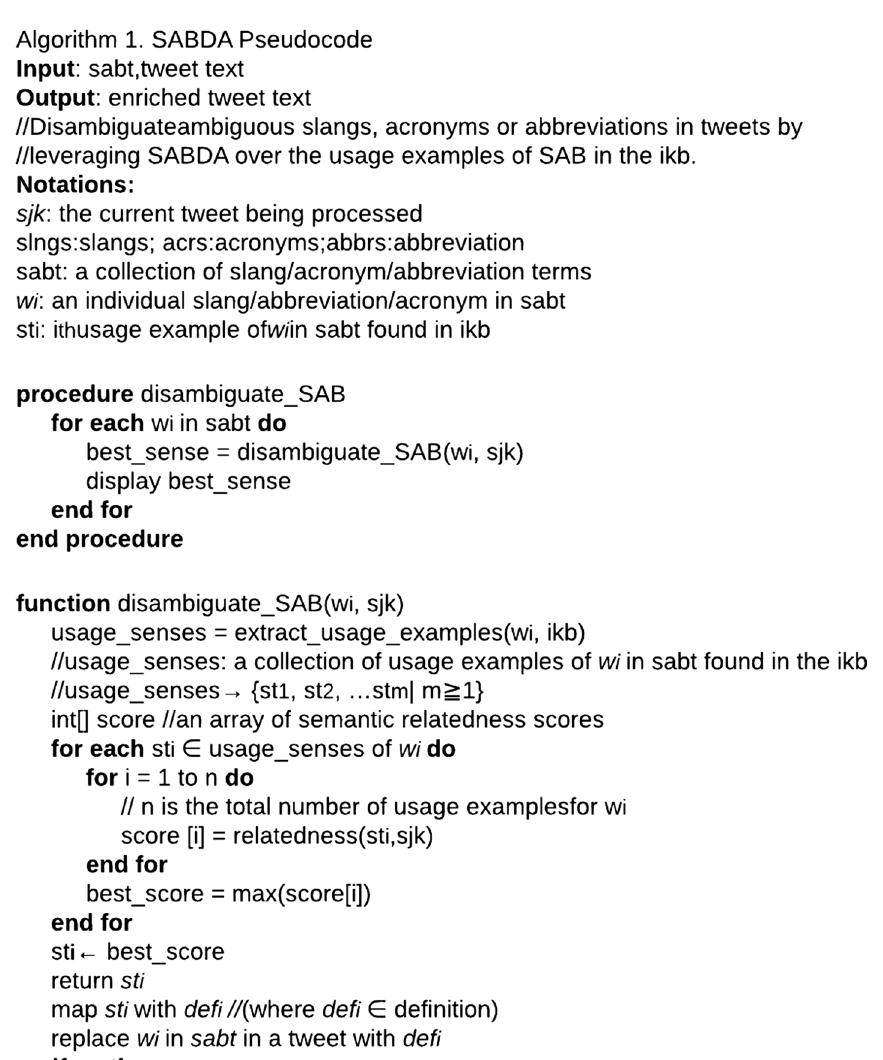
Illustration of SABDA pseudocode For clarity, the disambiguation and interpretation of the noisy terms process are illustrated in Example